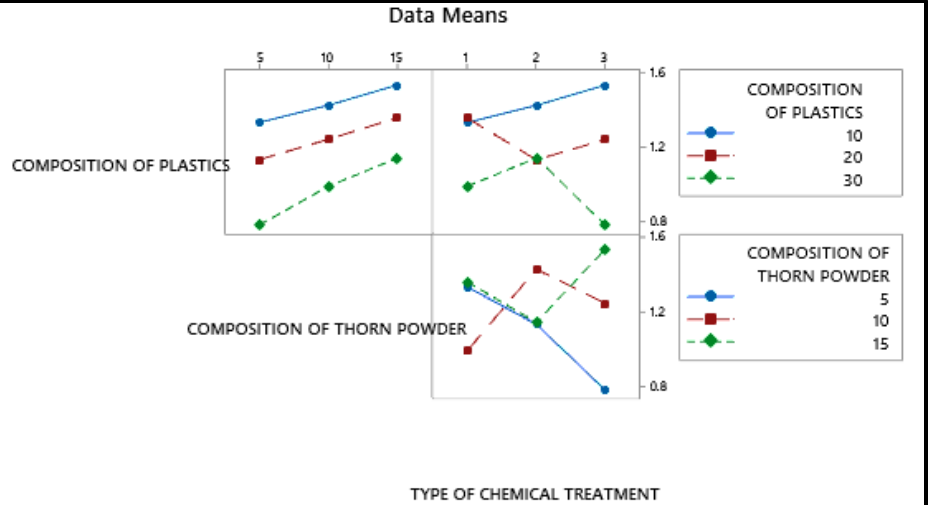
Figure 5. Effects plot for water absorption.